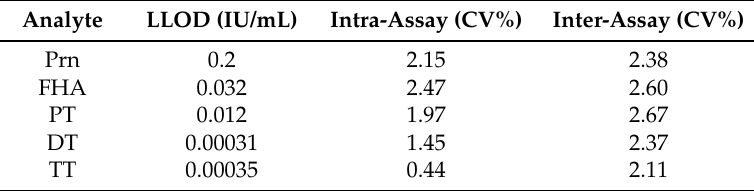
Table 1. Quality control of the pentaplex